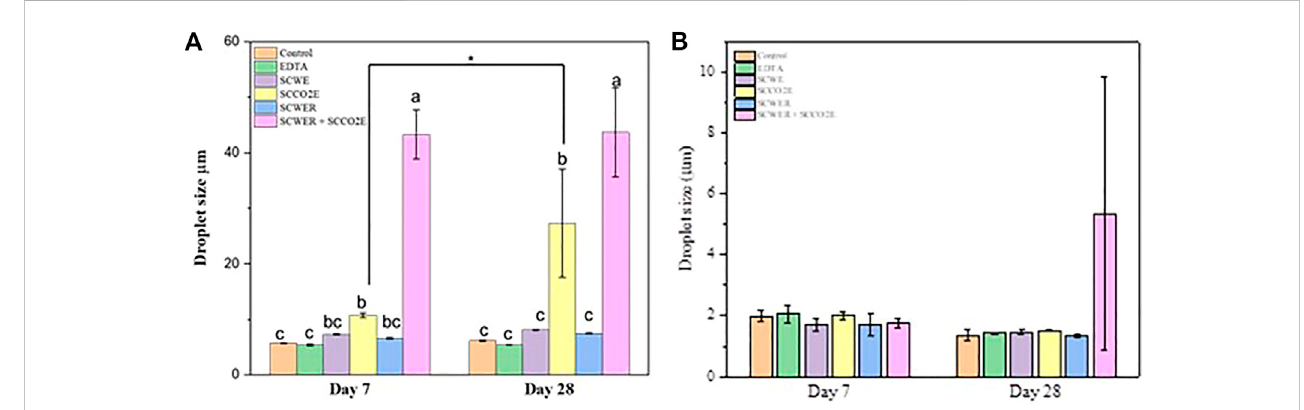
FIGURE 2 Droplet size (µm) in mayonnaise with different antioxidants added (and control without antioxidant added) on day 7 and 28 (stored dark at room temperature). (A) D [4,3] volume-weighted mean and (B) D [3,2] surface means droplet sizes. Mean ± sd ( n = 3).